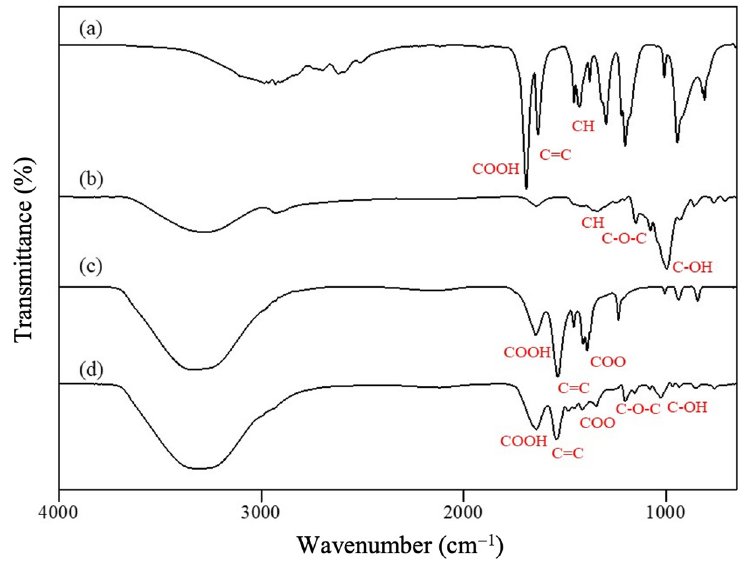
Figure 8. Analysis of S-SAP showing ( a ) FESEM micrographs at 20.0 k magnification, ( b ) EDX spec- tra for elemental composition of S-SAP, ( c ) XRD diffractogram, and ( d ) DSC thermogram.